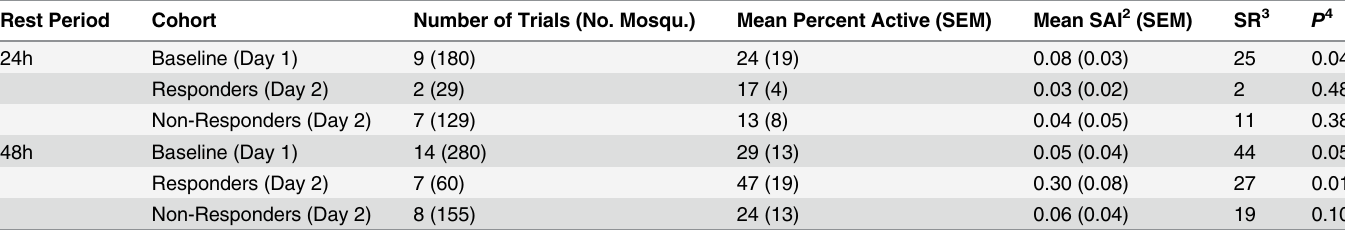
Table 1. Plasticity of spatial repellency behaviors in Aedes aegypti 1 females exposed to volatile transfluthrin (1.35 mg/m3). Rest